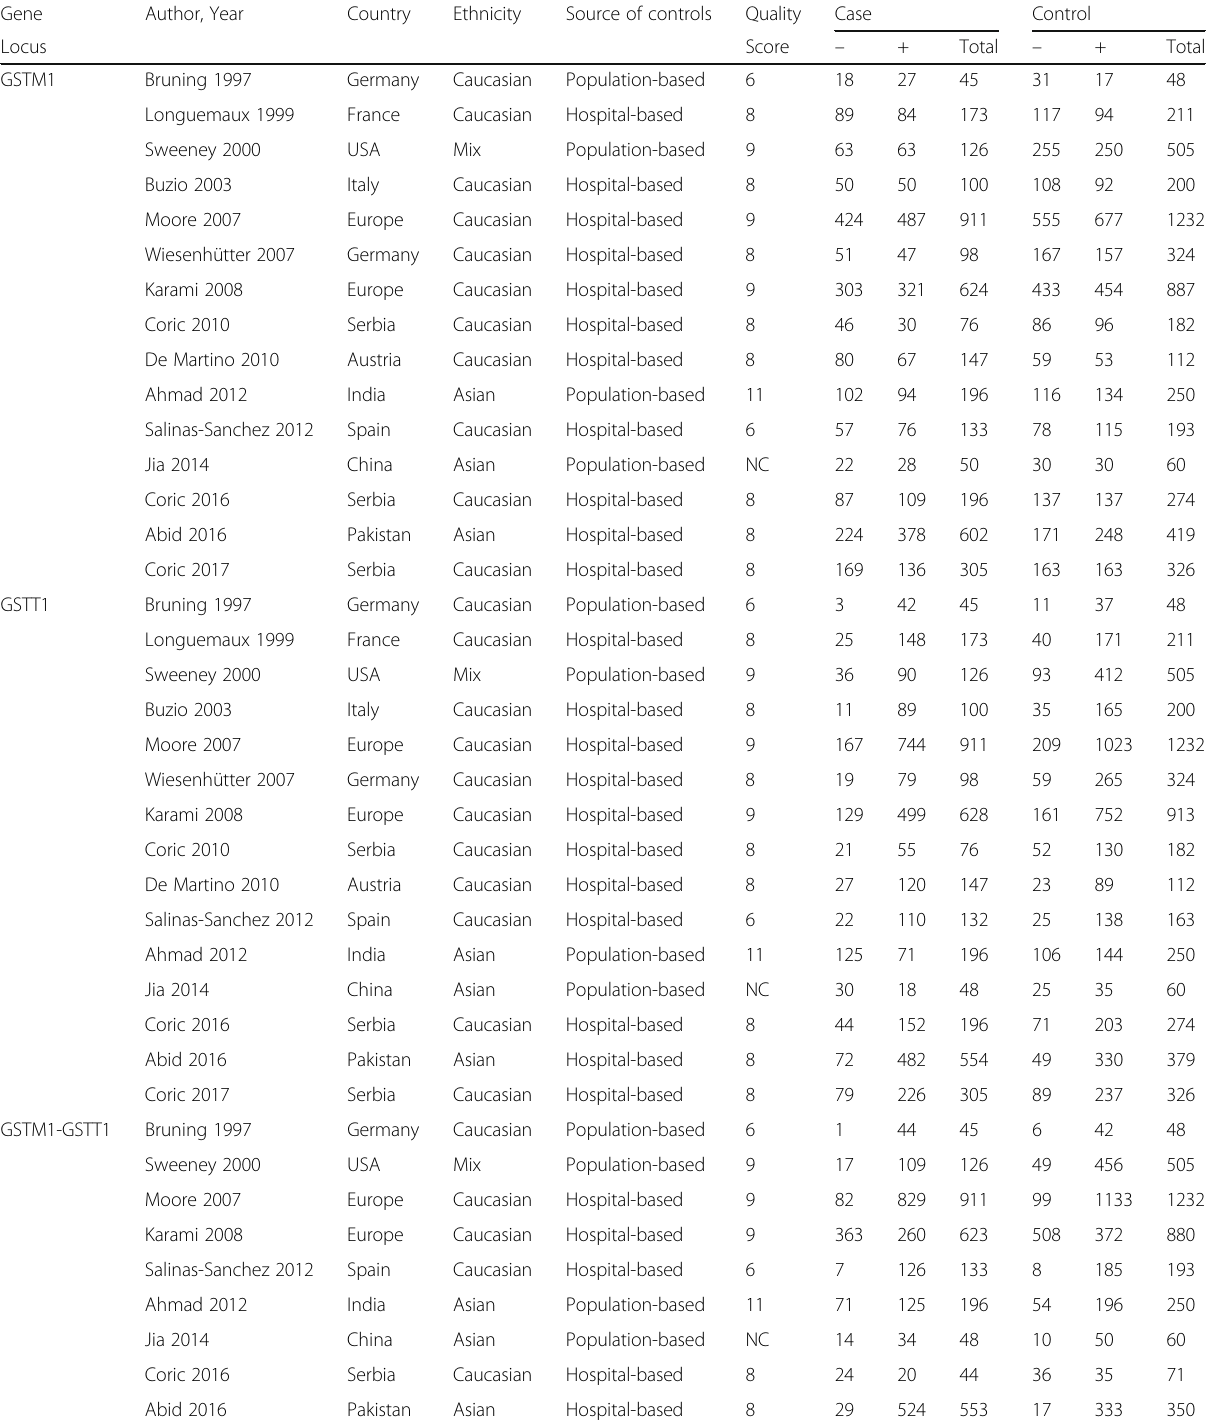
Table 1 Characteristics of studies evaluating the effects of GSTM1 and GSTT1 null genotypes on RCC risk